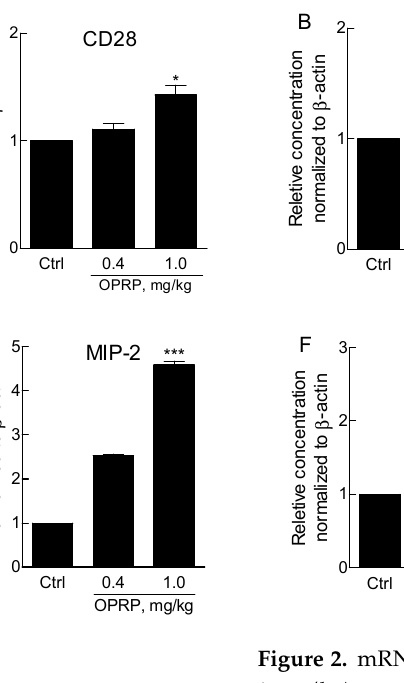
Figure 2. mRNA profiles in mouse splenocytes and CD4 + T cells. OPRP protein (0.4 mg/kg and 1 mg/kg) was peritoneally injected and splenocytes were prepared at 72 h after injection. Expression levels of TLR4-associated genes were determined using qPCR, as described in Materials and Methods. ( A ) CD28, ( B ) CD40L, ( C ) IFN γ , ( D ) CD80, ( E ) MIP-2, ( F ) TLR2, and ( G ) TLR4 were quantitated immediately after splenocytes were isolated from the spleen. ( H ) To assess TLR4 mRNA level, CD4 + T cells were separated from splenocytes and incubated with OPRP (1 μ g/mL and 5 μ g/mL) for 20 h. Data were normalized to β -actin expression. They are presented as mean ± standard deviation from three separate experiments. * p < 0.05, ** p < 0.01, *** p < 0.001 vs. Control.